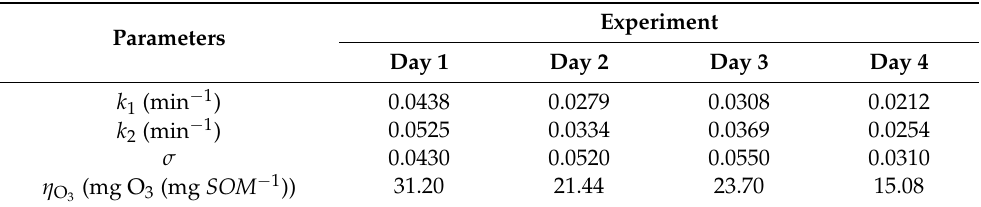
Table 7. Kinetic parameters determined from the serial kinetic model proposed for predicting the SS from the